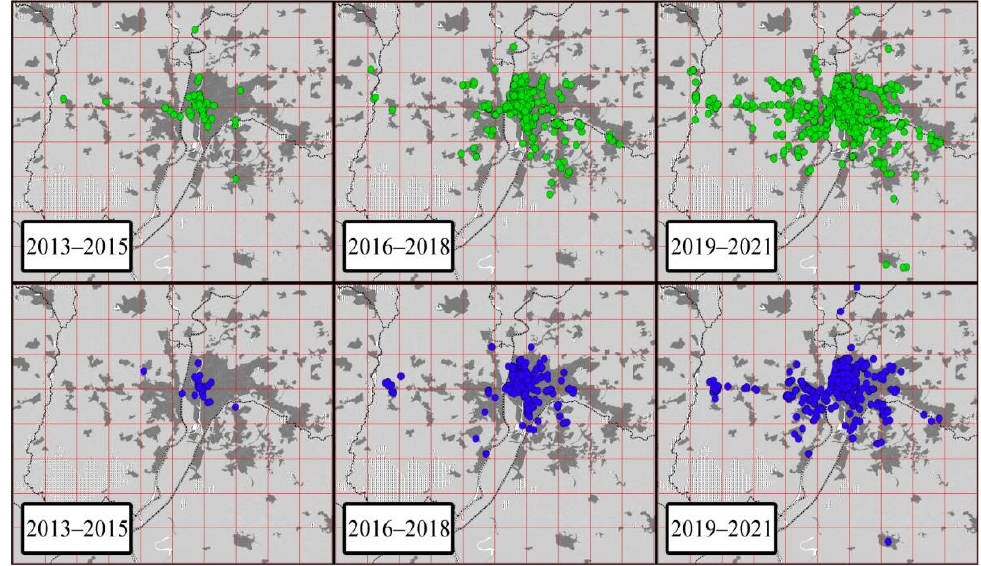
Figure 6. Observations of rose-ringed (green dots) and monk parakeets (blue dots) recorded in two citizen science platforms (eBird and Observation) in the study area over three consecutive year intervals between 2013 and 2021.